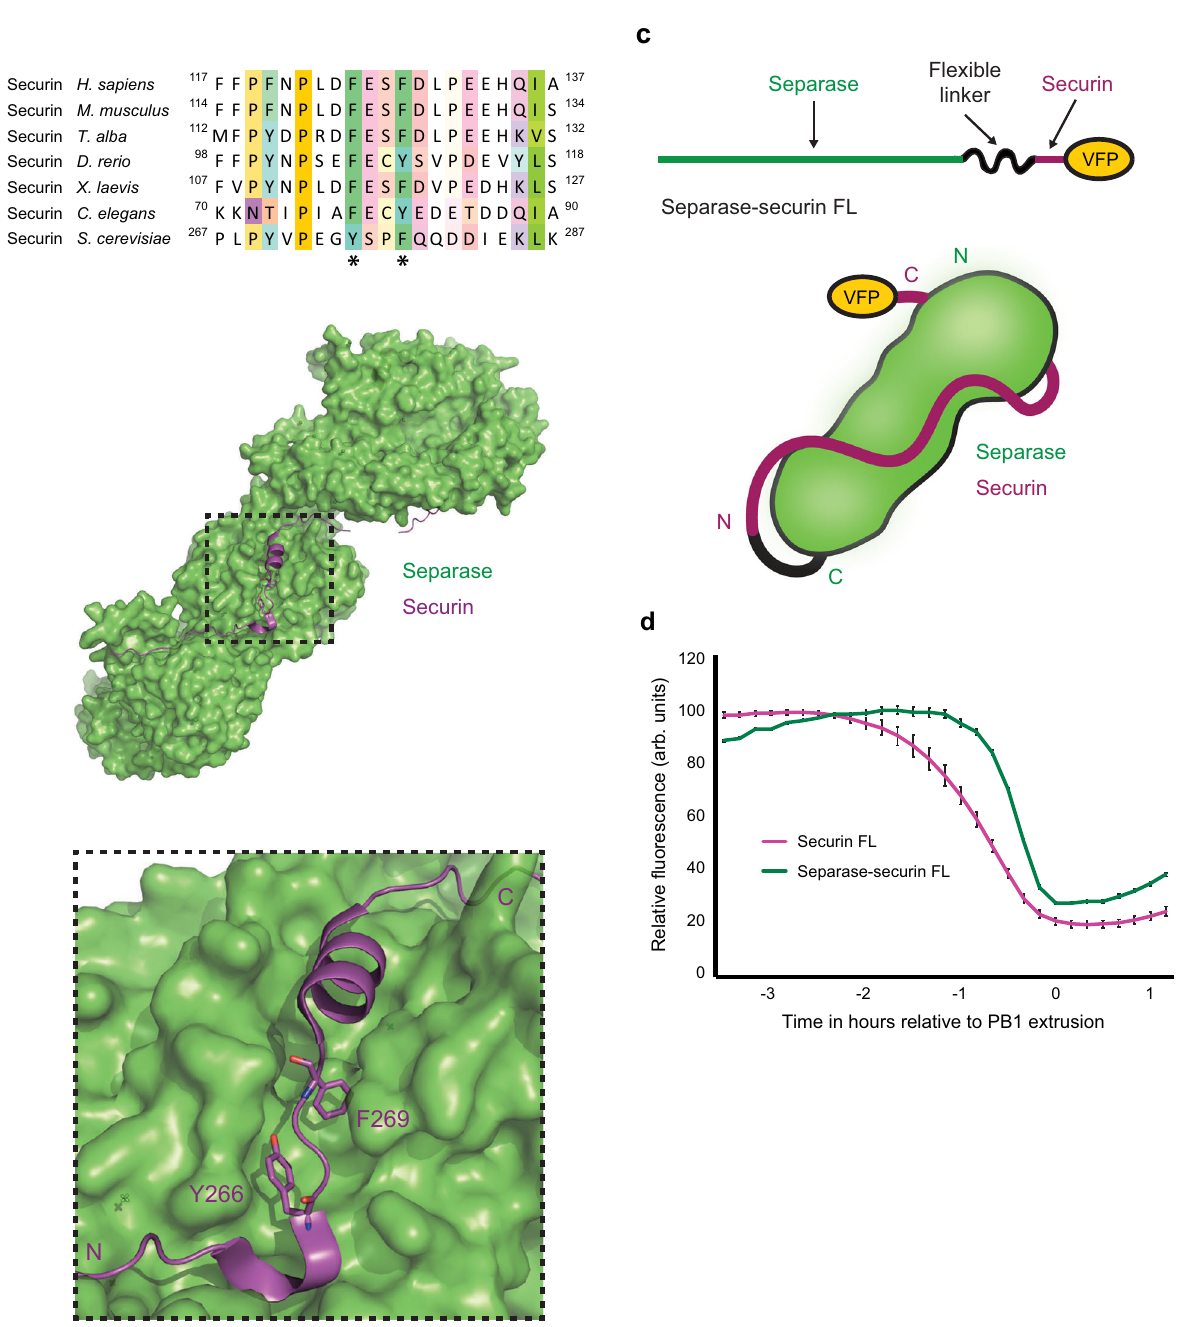
Fig. 3 F125 and F128 are predicted to direct the prometaphase destruction of a pool of non-separase-bound excess securin. a Multiple sequence alignment of the region surrounding residues F125 and F128 (marked with asterisks) in securin orthologs. b The molecular surface of separase (green) in contact with the region of securin detailed in Fig. 3a (purple). Image generated using the crystal structure of the Saccharomyces cerevisiae separase-securin complex (PDB accession 5U1T [10.2210/pdb5U1T/pdb]) 18 . The side chains of securin residues Y276 and F279, which correspond to F125 and F128 in the human protein, are shown as stick models and labelled in purple. The N- and C-termini of the securin segment displayed are also labelled in purple c Schematic representation of a tethered separase-securin complex reporter (separase-securin FL) including a cartoon demonstrating predicted complex interaction. d Mean VFP-tagged securin FL (magenta trace, n = 8) and separase-securin FL (green trace, n = 6) destruction pro fi les relative to PB1